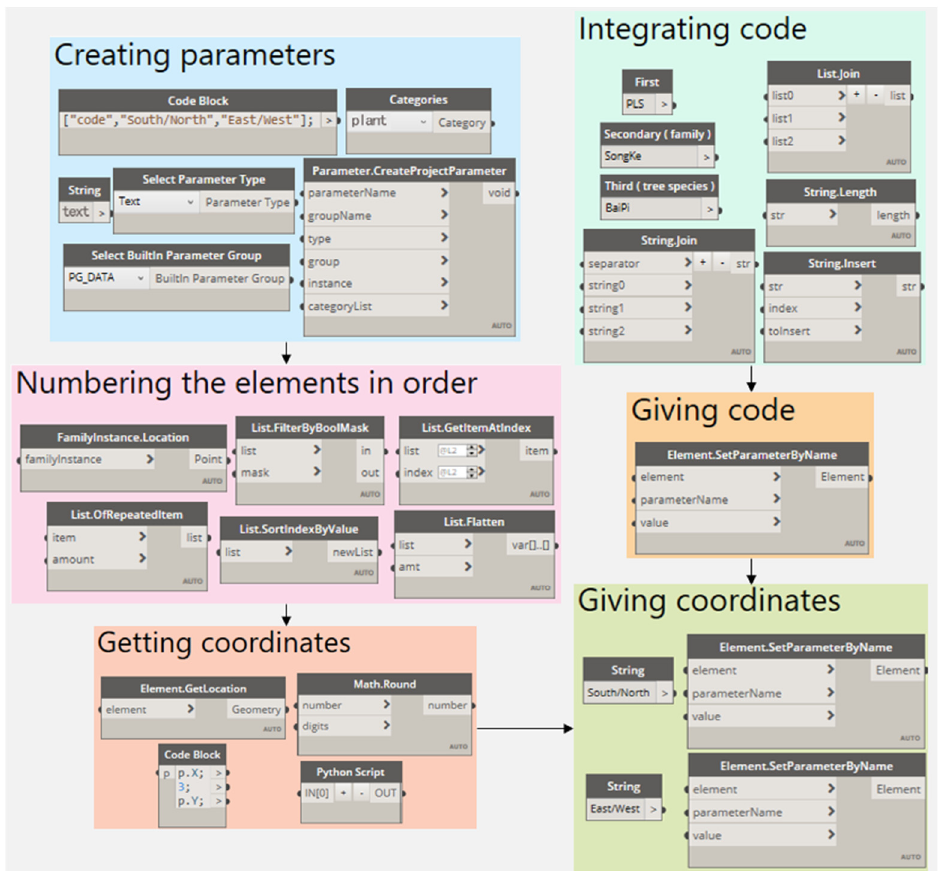
Figure 6. Parameterized model coding script (excerpt).